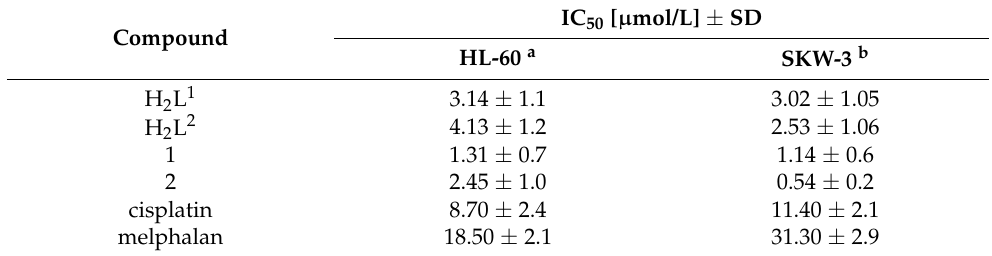
Table 3. Cytotoxic activity of the tested ligands and Ga (III) complexes after 72-h treatment.